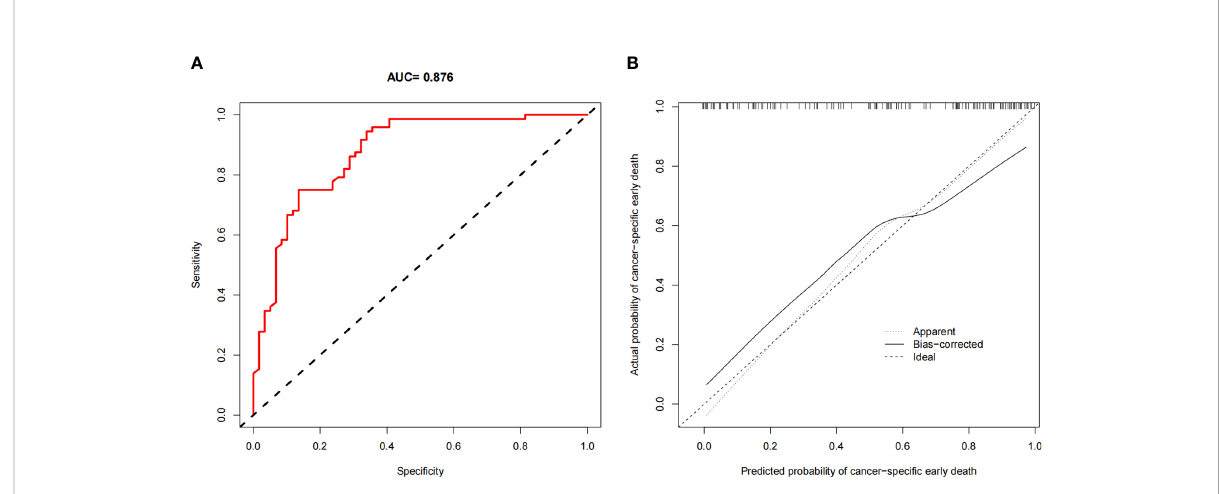
FIGURE 6 Validation in Chinese population. (A) The ROC curve for the nomogram; (B) The calibration plots for the